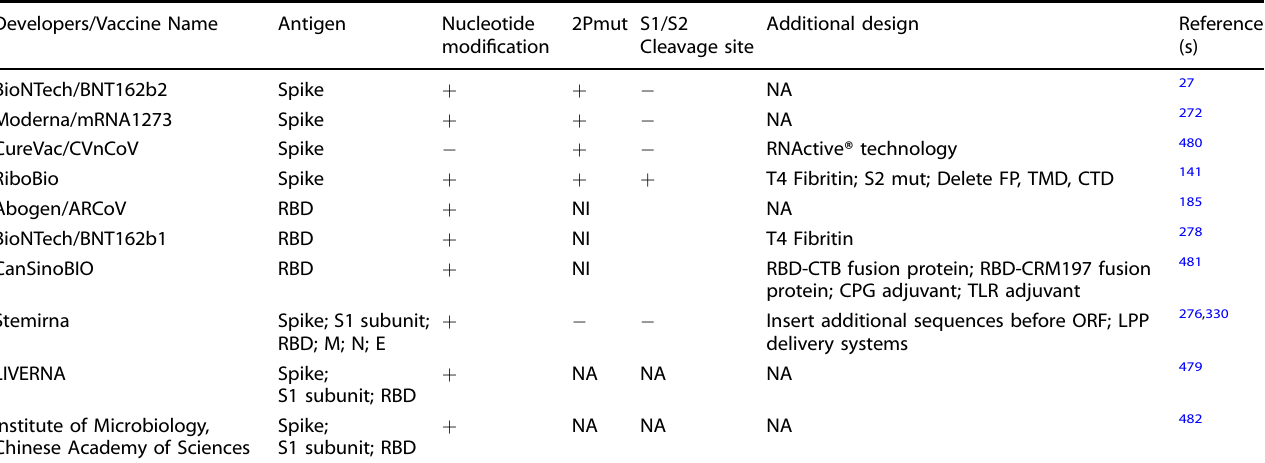
Table 2. Antigen design strategies adopted for COVID-19 mRNA vaccines Developers/Vaccine